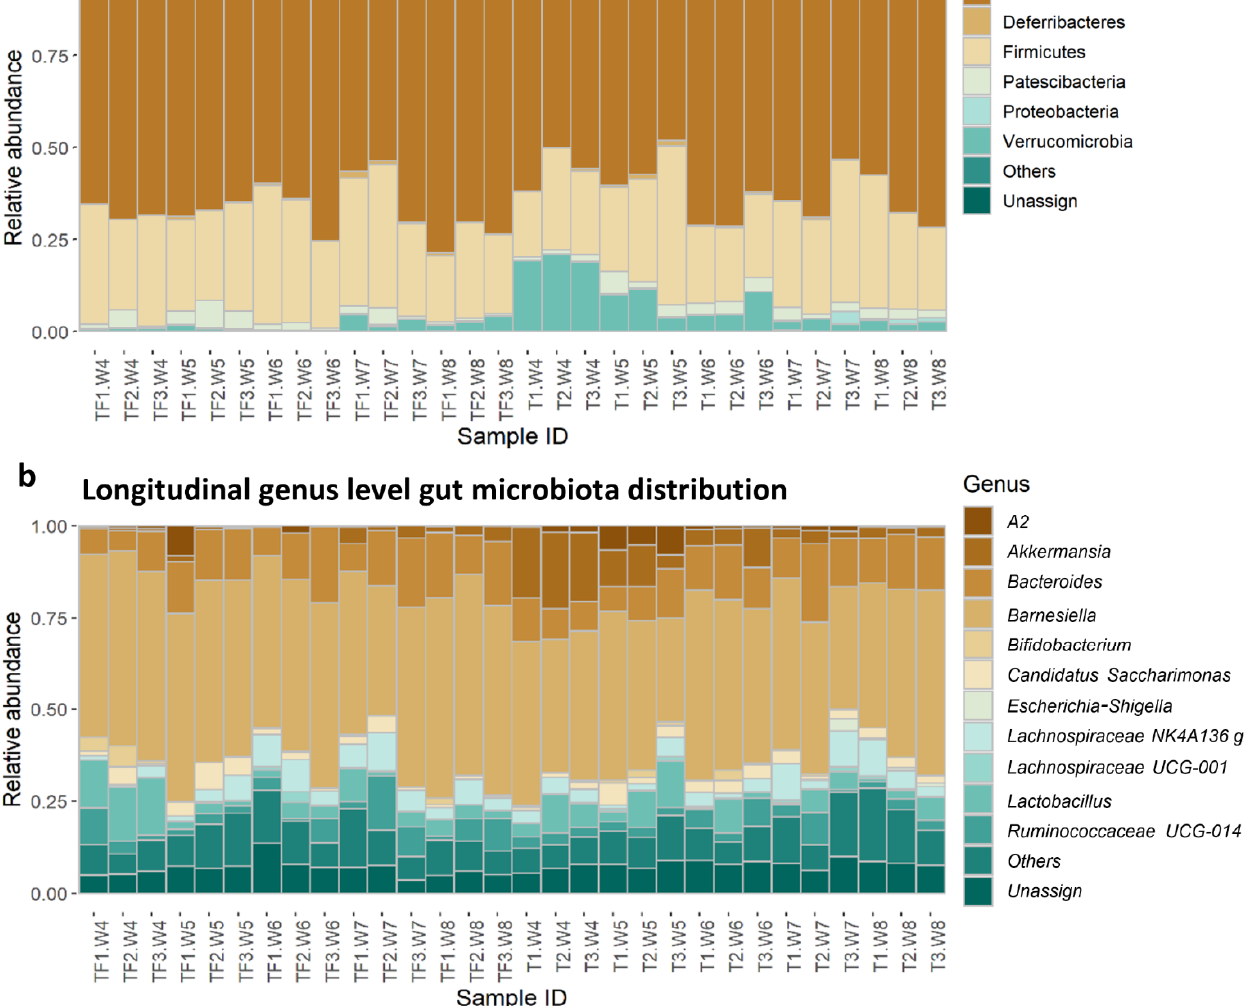
Figure 2. Relative abundance of identified taxa at ( a ) the phylum level and ( b ) the genus level. The top five most abundant taxa from all samples were plotted and all the other taxa were grouped as “others”. Taxa that cannot be assigned to a phylum or a genus with SILVA database were assigned to “Unassign”. A2 genus represents a group of uncultured bacteria identified in mouse gut microbiota under Lachnospiraceae . The sample IDs consist of the group, mouse ID, and sampling time, e.g., TF1.W4 is the sample collected from mouse #1 in the TF group in the 4th